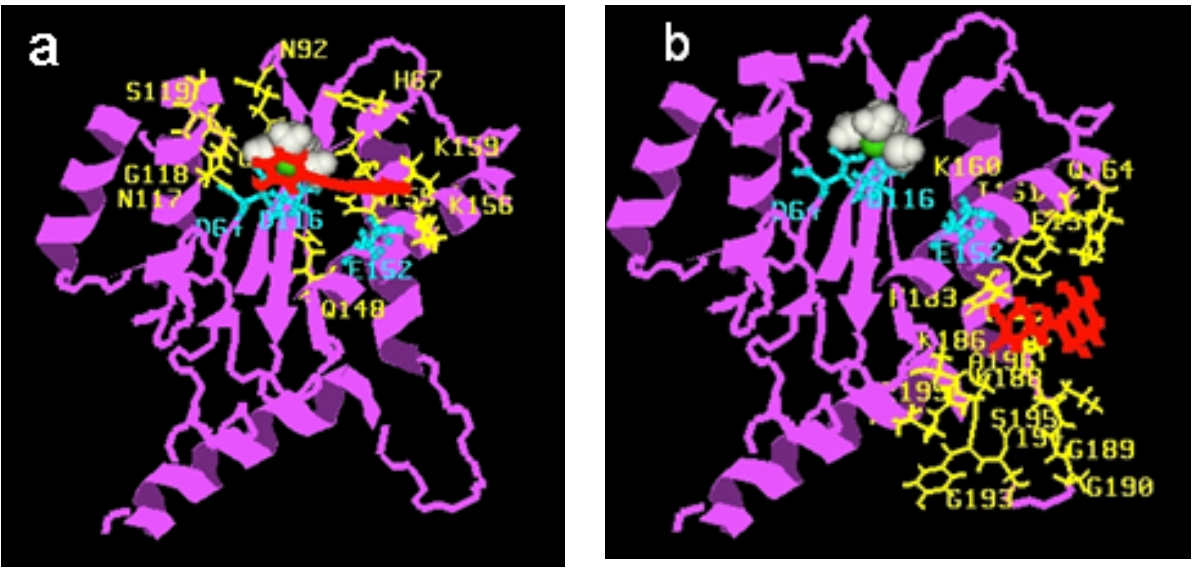
Figure 5. View of one SQ-IN complex typical conformation belonging to each cluster: a, cluster 1; b, cluster 2. The protein is shown in magenta, Mg 2+ in green, water in white; drug in red, the catalytic triad (Asp64-Asp116-Glu152) in cyan (sticks and balls) and contacting residues are in